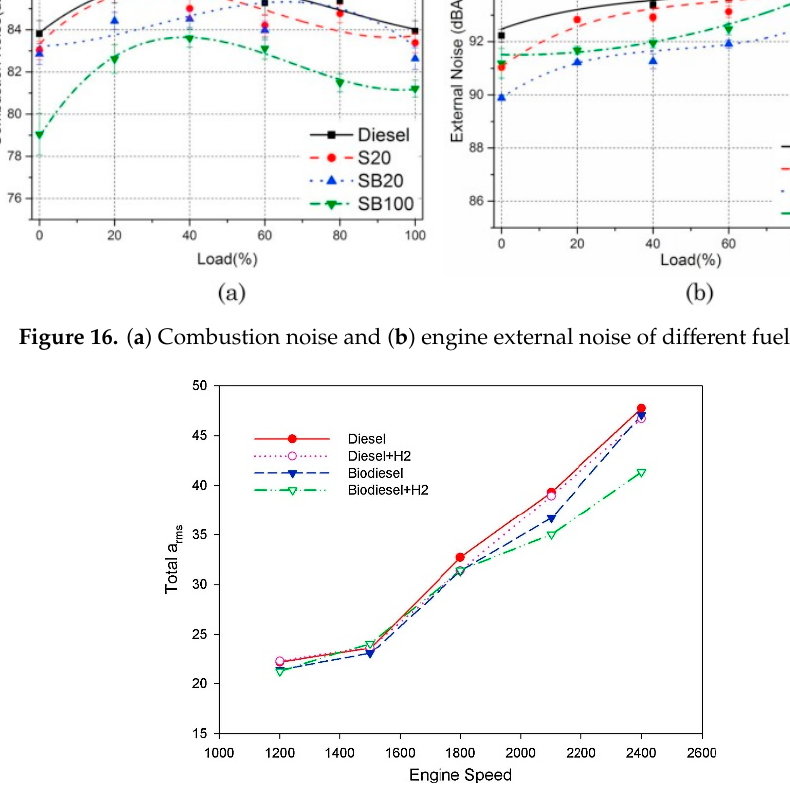
Figure 17. a total (total vibration acceleration) of diesel, biodiesel and their hydrogen enriched blends [136].